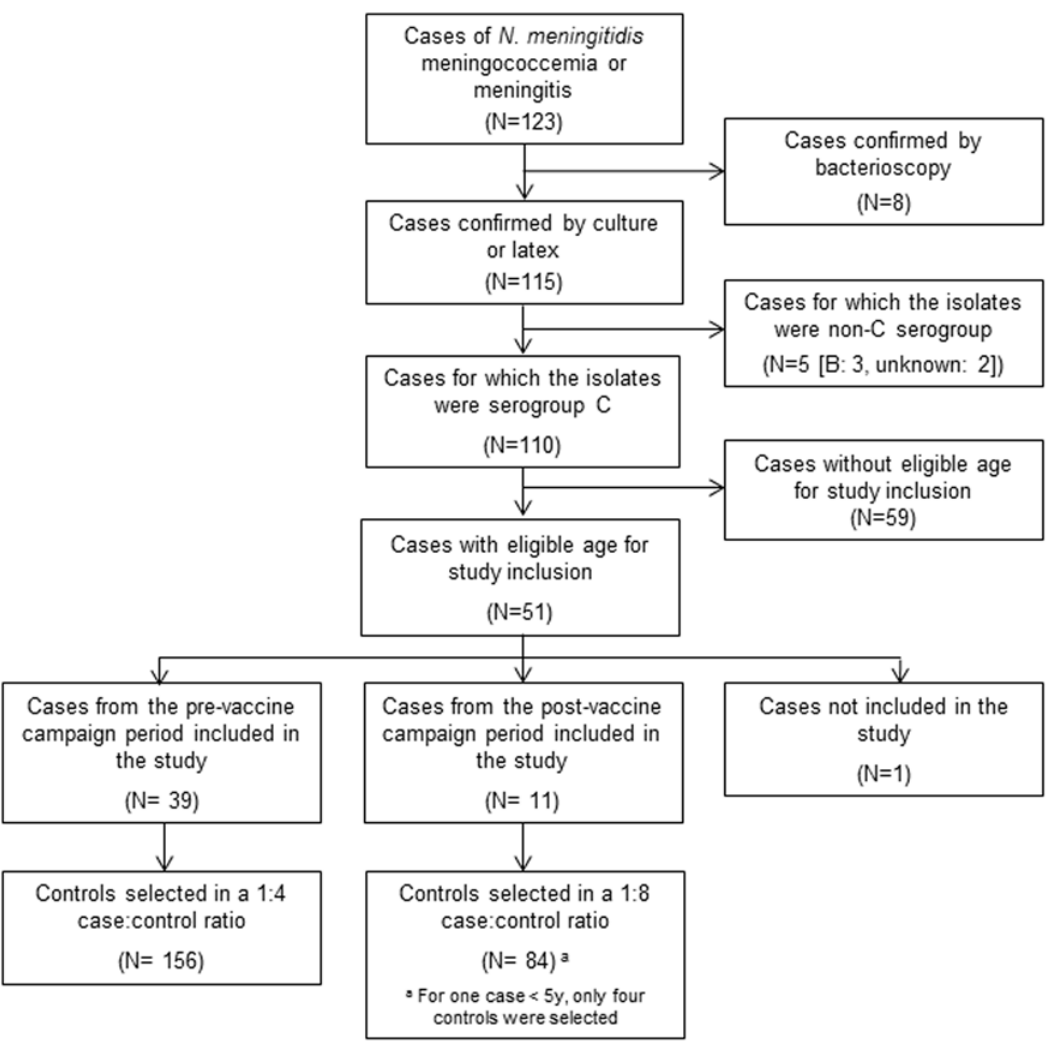
Fig 1. Design of case-control study. Of the 110 confirmed MenC cases, 88 (80%) were admitted to the public infectious diseases reference hospital (Couto Maia Hospital). Clinical presentations included meningococcemia (n = 43; 39%), meningitis (n = 32; 29%), and both meningococcemia and meningitis (n = 35; 32%) (Table 1). Reported symptoms included fever in all cases; headache, vomiting and other signs and symptoms of meningococcal infection were common. Diarrhea was reported in 11 (10%) of 110 cases. A total of 19 cases (17%) were admitted to an intensive care unit (ICU). Overall case-fatality was 25% (27 patients), including patients admitted to ICU and who died prior to ICU admission. Patients who died ranged in age from 0 to 68 years (median, 25 years). In addition, 11 (10%) patients recovered with neurologic sequella (motor deficit [n = 4], bilateral hearing loss [n = 2], visual impairment [n = 2] and lower limb amputation [n = 3]) (Table